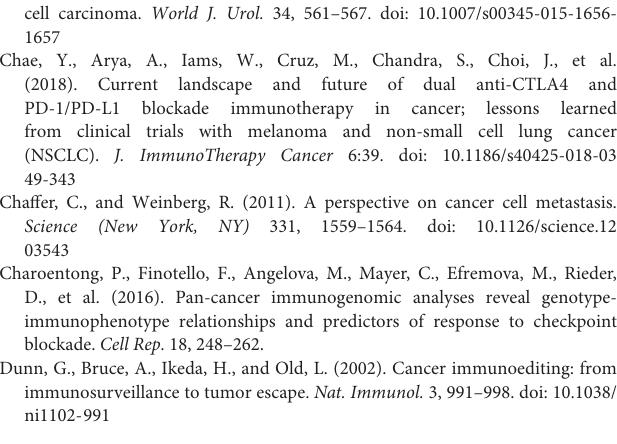
Supplementary Figure 3 | Gene Set Variant Analysis (GSVA) for the two subtypes on the basis of the 512 samples. Supplementary Figure 4 | Sankey plot showing the changes of immune-related molecular subtypes, gene cluster, IR score, and patient survival status. Supplementary Figure 5 | Identification of the independence of the IR score and clinical information through univariate Cox regression analysis (A) and multivariate Cox regression analysis (B) . Supplementary Figure 6 | The landscape of immune cells in the two IR score groups. Supplementary Figure 7 | The comparisons of the stromal score (A) , immune score (B) , and tumor purity (C) in the IR score groups. Supplementary Figure 8 | Identification of small molecular compounds by using the CMap drug database between the high IR score and low IR score